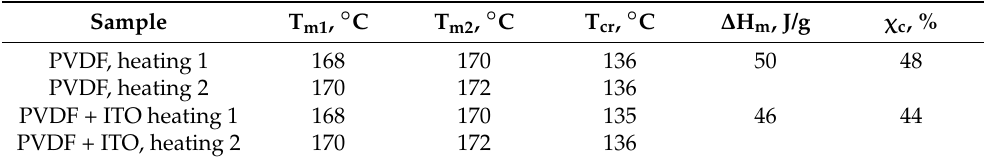
Table 1. Melting and crystallization temperatures, melting thermal effects, and percent crystallinity for PVDF films with and without